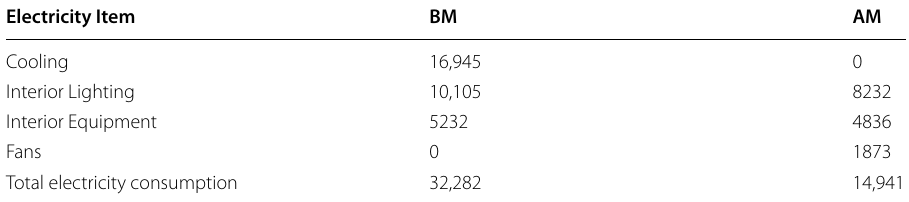
Table 5 Annual electricity subdivisions consumption for BM and AM as simulated by DesignBuilder in